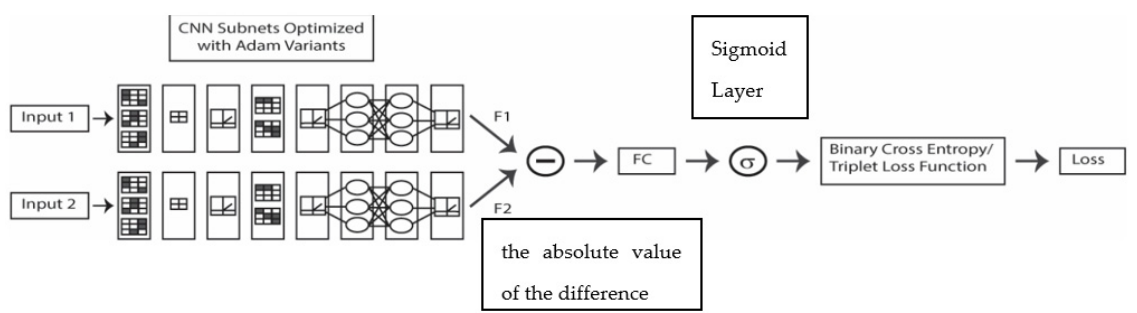
Figure 2. Schematic of SNN.